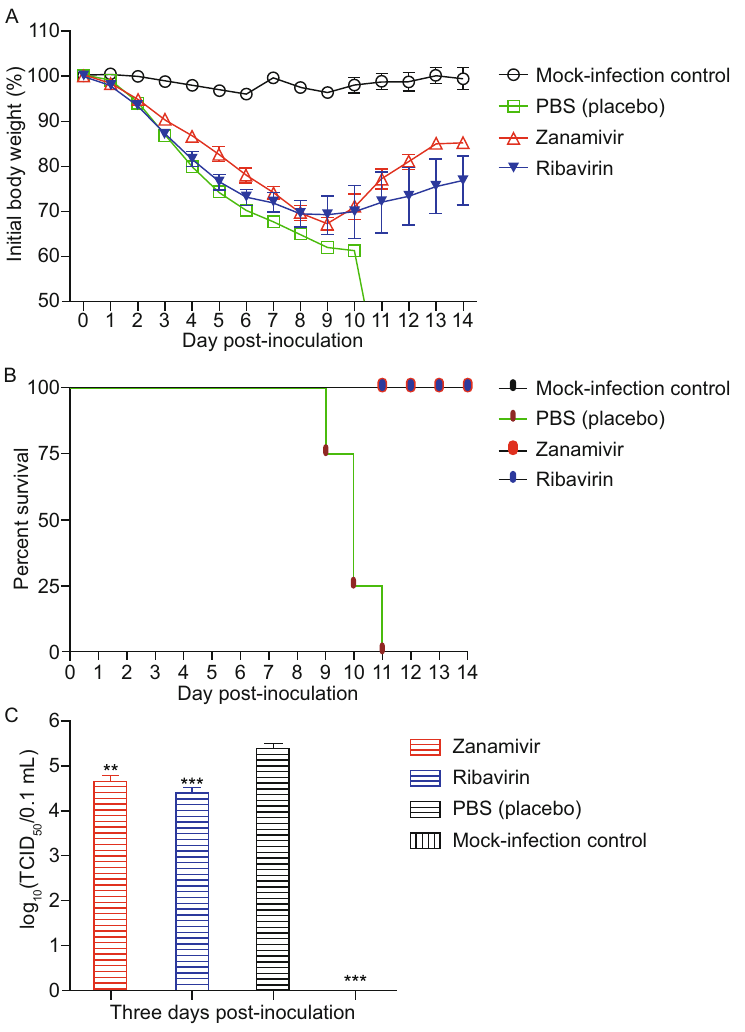
Figure 1. Ef fi cacy of ribavirin in mice infected with AH-H7N9 . Mice ( n = 9) were given ribavirin, zanamivir or PBS (placebo) twice daily, respectively. Animals were inoculated i.n. with 10× LD 50 of AH-H7N9 in 50 µL PBS at one day after the initiation of treatment, and an untreated group was mock-challenged with an equal volume of PBS as control. Survival and body weights were monitored daily over a 14-day observation period and expressed as percentages of the initial values (A). The mortality rate was calculated from the survival curve of each group (B). Five mice from each group were euthanized at 3 d.p.i. LVTs were quanti fi ed in MDCK cells, and expressed as log 10 TCID 50 /0.1 mL (C). The data are presented as the mean ± SD. Statistical analysis on the LVTs were performed with a paired-sample t -test (*, P < 0.05; **, P < 0.01; ***, P <